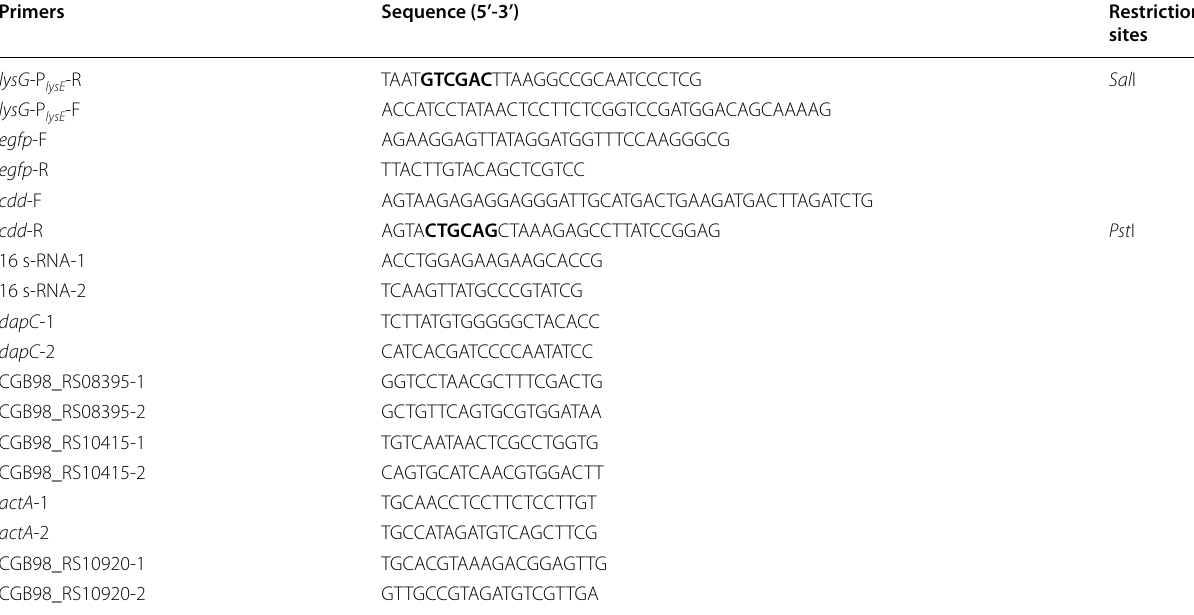
Table 2 Primers used in this